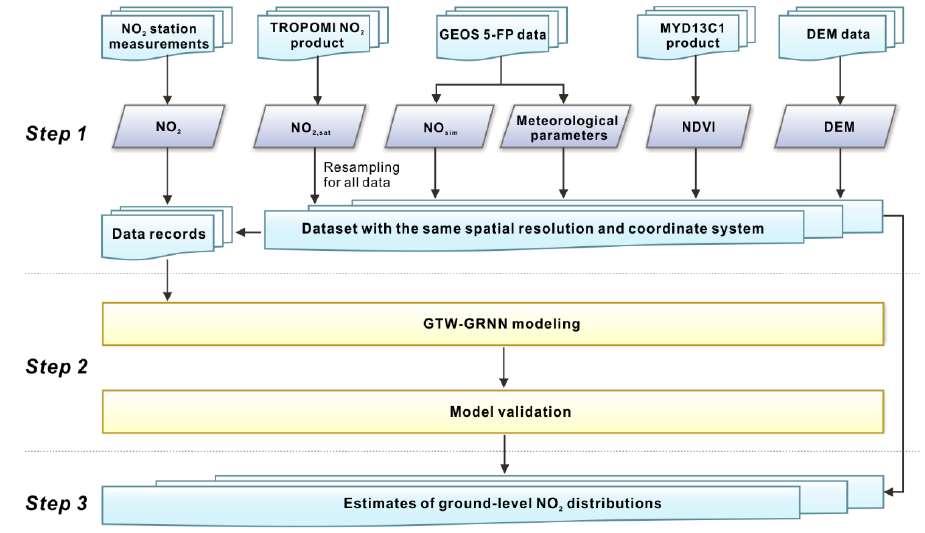
Figure 3. The procedure of satellite-based NO 2 estimation via the GTW-GRNN model.